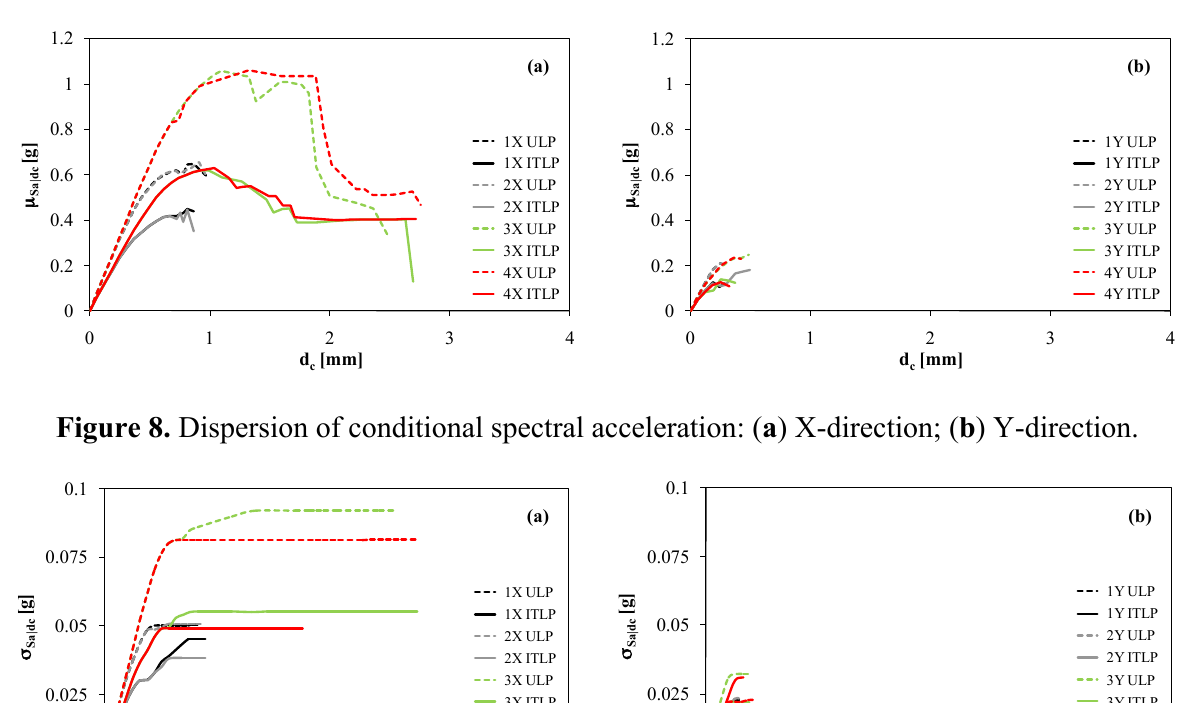
Figure 7. Mean of conditional spectral acceleration: ( a ) X-direction; ( b ) Y-direction.